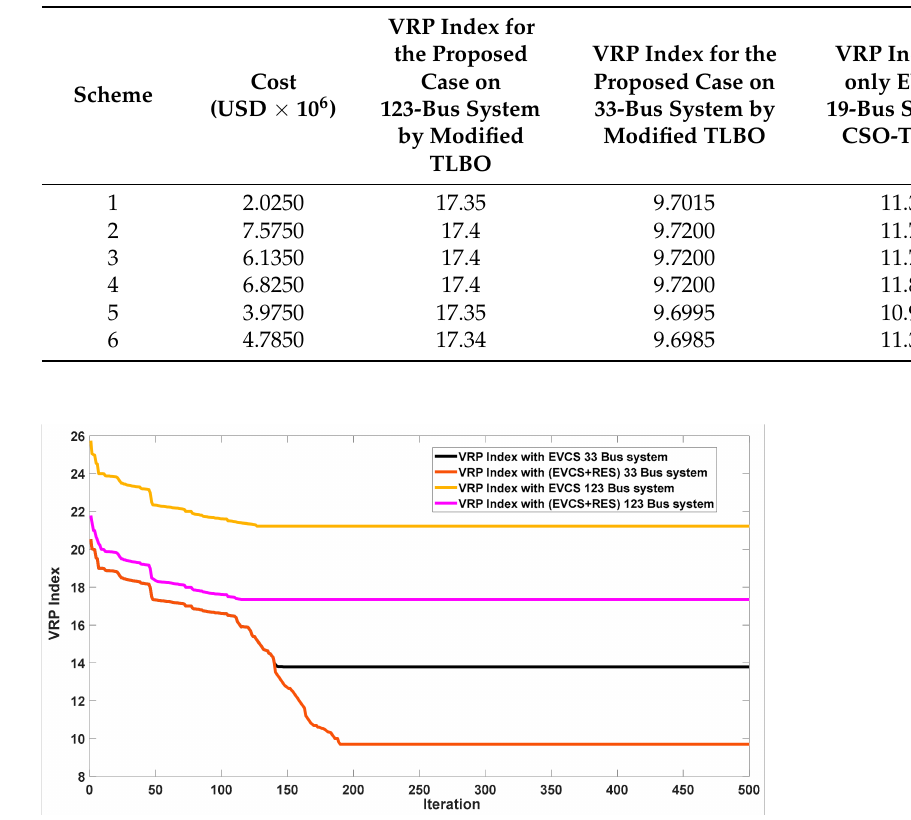
Table 13. Values obtained from objective functions for six innovative schemes for the proposed case (EVCSs with RESs).